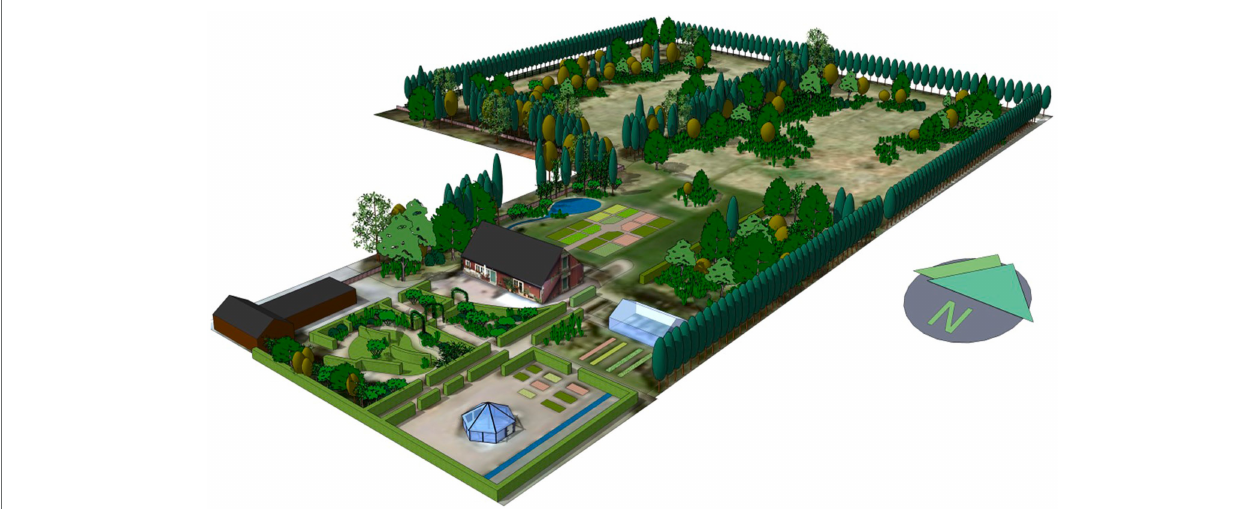
FIGURE 2 | Alnarp Rehabilitation Garden, part of the Swedish University of Agricultural Sciences’ research infrastructure. The garden is approximately two hectares in size and is designed with a number of garden rooms with different designs and contents. Studies of patients in the garden revealed behavioral changes associated with different types of treatments, which may be associated with release or not of oxytocin. The model of the garden is made by Gunnar